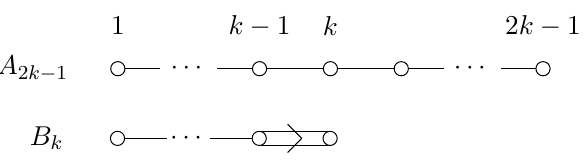
Figure 2 . Folding the Dynkin diagram A 2 k − 1 by sum yields the Dynkin diagram B k . to α → α + α except for α i i 2 k − i